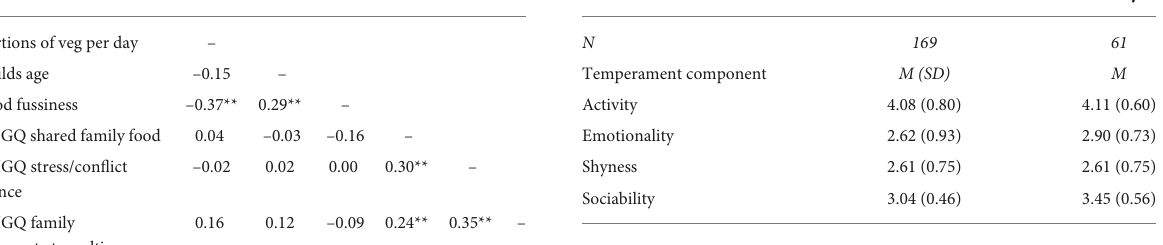
TABLE 8 Correlations between vegetable consumption and parent and child measures, Polish sample ( N = 122). Variables